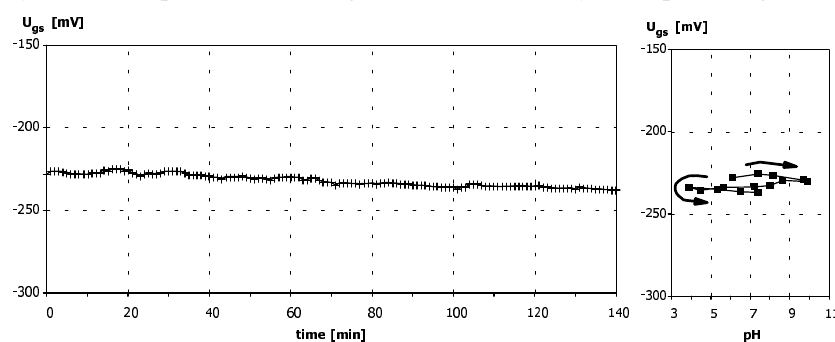
Figure 7. Dynamic response and calibration curve to pH of an ISFET with polyHEMA coating ca. 160 µm thick, deposited according to the Method 3. Cycle of pH changes: 6-10-4-7. The worst results were obtained for sensors with polyHEMA coatings 60 µm thick and thicker. The ion-selective membranes showed an almost complete lack of adhesion to the polyHEMA coating soaked with aqueous electrolyte solution. Considerable differences in flexibility and hardness between polyHEMA coatings and Siloprene membranes could cause a strong mechanical stress in their